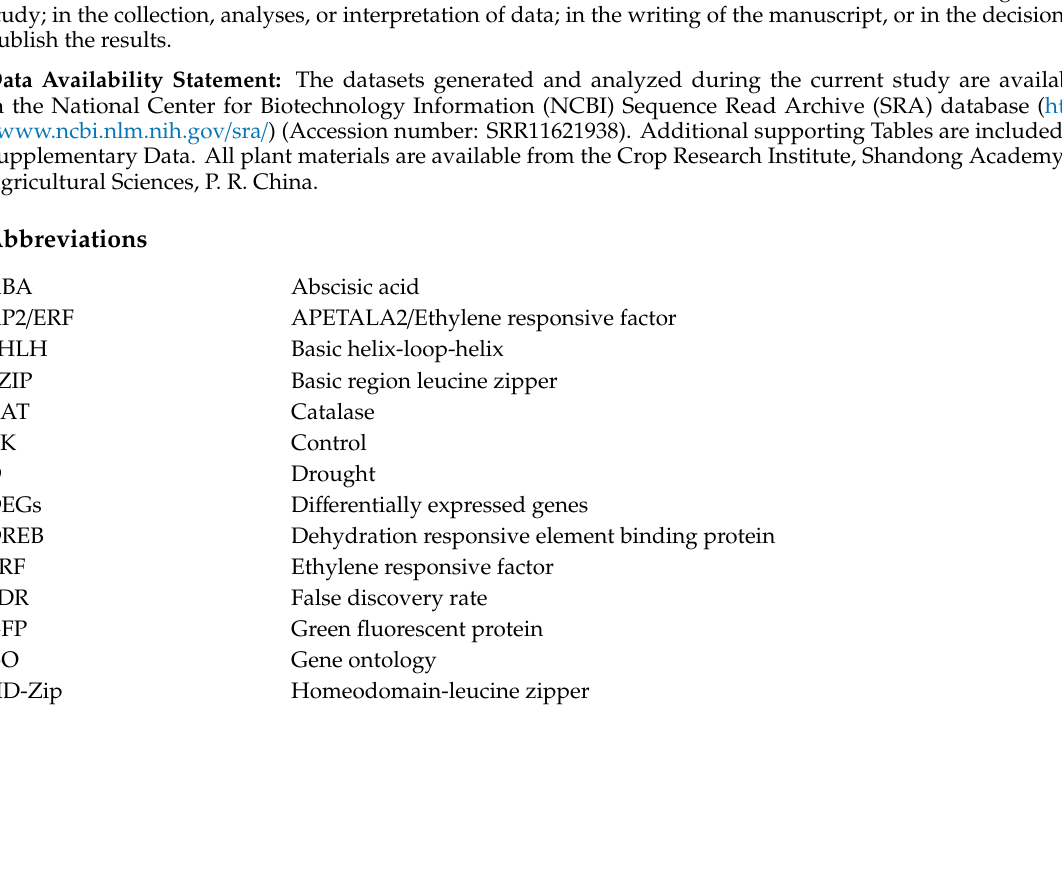
Table S1. List of the primers used in RT-qPCR analyses. Table S2. Genes di ff erentially expressed between LCK and LD. Table S3. Genes di ff erentially expressed between LD and LR. Table S4. Genes di ff erentially expressed between LCK and LR. Table S5. Genes di ff erentially expressed between RCK and RD. Table S6. Genes di ff erentially expressed between RD and RR. Table S7. Genes di ff erentially expressed between RCK and RR. Table S8. Detailed list of transcription factor genes di ff erentially expressed between LCK and LD. Table S9. Detailed list of transcription factor genes di ff erentially expressed between RCK and RD. Table S10. DEGs in common in roots between drought, rehydration compared with control in leaves Table S11. DEGs in common in roots between drought, rehydration compared with control in roots. Method 1. The coding sequence of SiP5CS2